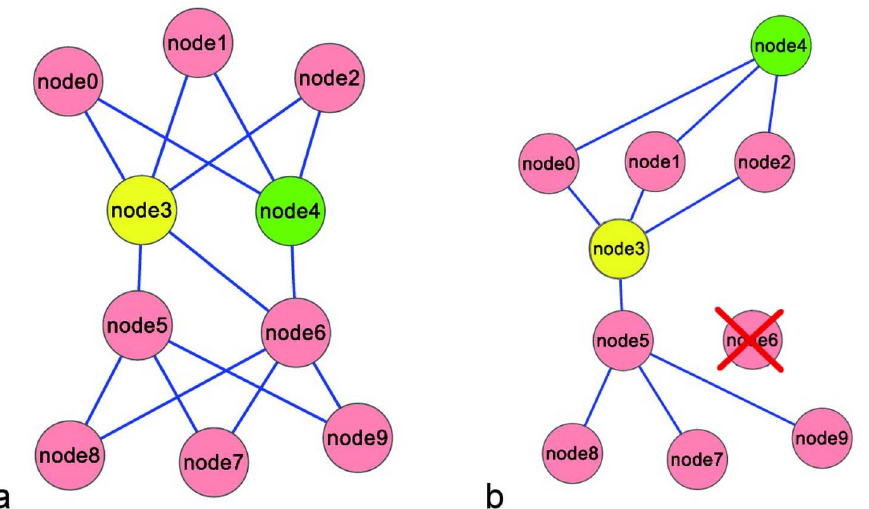
Figure 2. Positive and negative interference. a Node3 and node4 are the nodes connecting the top of the network with the bottom. b Node6 has been removed: node4 becomes a peripheral node, its betweenness decreases. The presence of node6 is important for node4 to play a central role (positive interference). At the same time, node3 and node5 become fundamental connections betweenn the top and the bottom. Their betweenness values increase. The presence of Node6 in the network on the left damages the ‘‘central role’’ of node3 and node5 (negative interference).